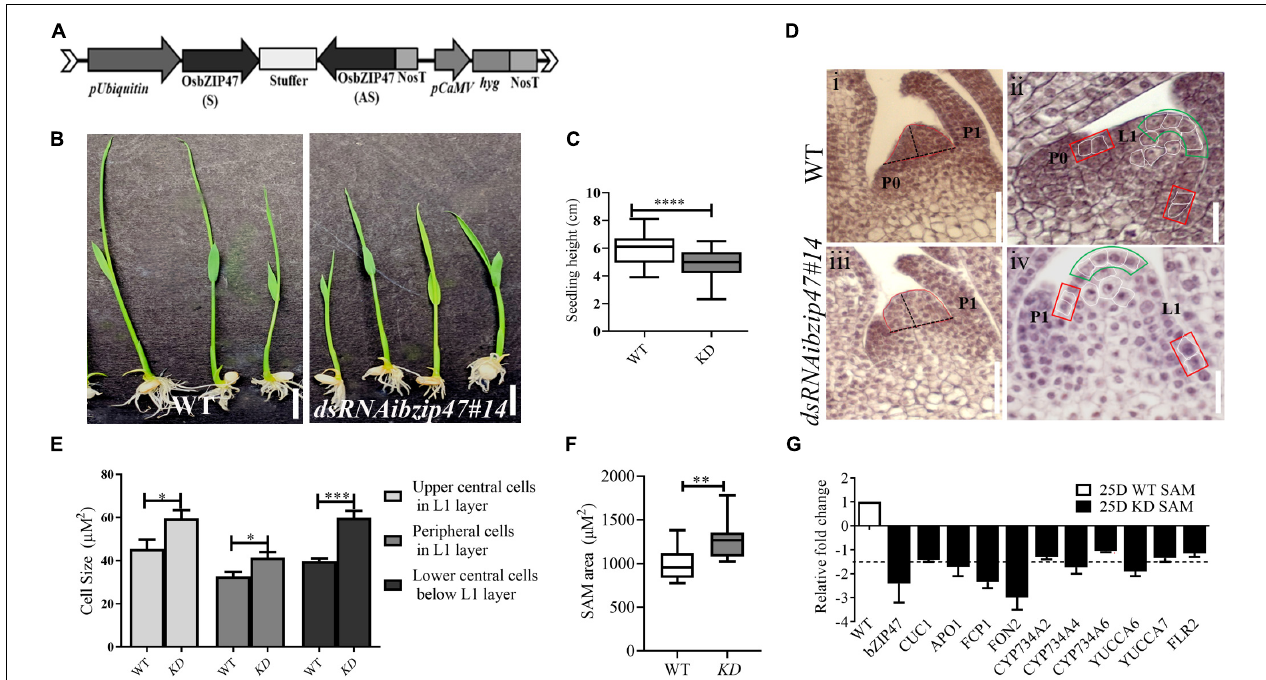
FIGURE 1 | OsbZIP47 knockdown (KD) vegetative phenotypes. (A) Schematic representation of dsRNAiOsbZIP47 transgene T-DNA segment. (B) Seedling height of 8-day OsbZIP47KD ( dsRNAibZIP47#14 ) plants is shorter than that of wild-type (WT) plants. Scale bar = 1 cm. (C) Seedling height data shown as mean ± s.d., Student’s t- tests, **** P < 0.0001, n = 30. (D) Representative histological sections of SAMs from WT and dsRNAibZIP47#14 . SAM area in 25 days after germination (DAG) seedlings marked by red outline in panels (i,iii) . SAM height and width are marked by dashed black lines. Measured cells are marked with white outlines in panels ii and iv. Scale bar in panes (i,iii) are of 50 µ M, and panels (ii,iv) are of 20 µ M. (E) Comparison of L1 cell size in the central, and peripheral cells, and in the lower central cells underlying the central L1 layer. The statistical analysis of cell size, for cells in different regions of the meristem, was derived from 10 to 12 different sections. Data is shown as mean ± s.d. Student’s t- tests. * P < 0.05, *** P < 0.001. (F) Comparison of SAM area in OsbZIP47KD ( dsRNAibZIP47#14 ) vs. WT in 25 DAG seedlings. Data is shown as mean ± s.d. Student’s t tests, ** P < 0.01, n = 10. (G) RT-qPCR analyses of CUC1, APO1, FCP1, FON2, CYP734A2, CYP734A4, CYP734A6, YUCCA6, DRUS2/FLR2 , and FON2 transcripts in SAM from 25 DAG seedlings. Fold-change values were determined by comparing the normalized expression levels in OsbZIP47KD plants to WT